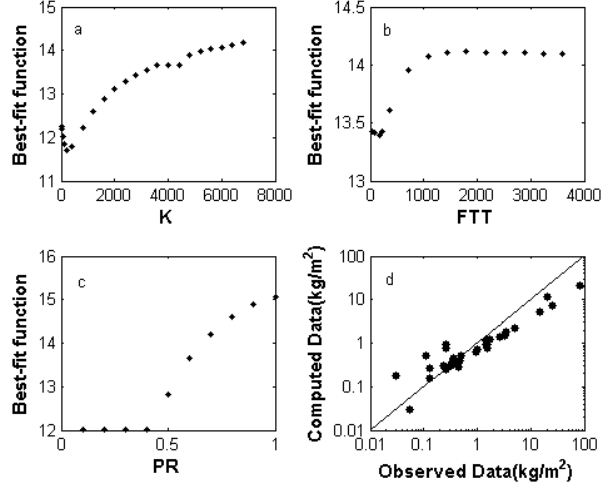
Figure 4. Misfit function calculated varying the atmospheric horizontal diffusion coefficient 630 Fig. 4. Misfit function calculated varying the atmospheric horizon- tal diffusion coefficient ( K ) between 0.001 and 6800 m 2 s − 1 , the (K) between 0.001-6800 m 2 s -1 , the Fall-Time Threshold (FTT) between 36-10800 s and PR 631 fall-time threshold (FTT) between 36 and 10800s, and PR between between 0 and 1. Log plot shows the comparison between computed and observed data with 632 0 and 1. Log plot shows the comparison between computed and ob- the best fit values obtained from the results of sensitivity test for K= 1800 m 2 s -1 , FTT= 2520 633 served data with the best-fit values obtained from the results of the sec (i.e., 0.7 hours) and PR = 1. 634 sensitivity test for K = 1800m 2 s − 1 , FTT = 2520s (i.e. 0.7h) and PR =